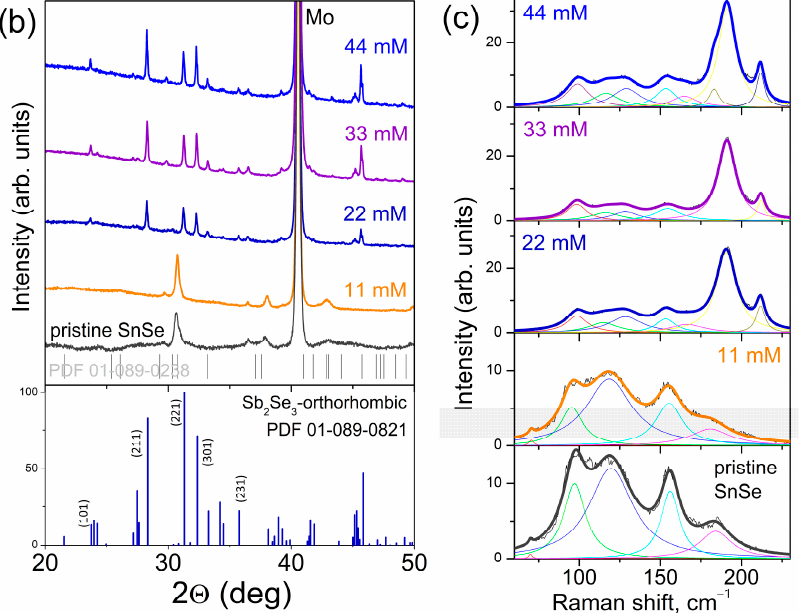
Figure 2. ( a ) SEM images and EDX data, ( b ) XRD patterns, and ( c ) Raman spectra of the layers that experienced cation exchange for 22 min in solutions with various concentrations of SbCl 3 .